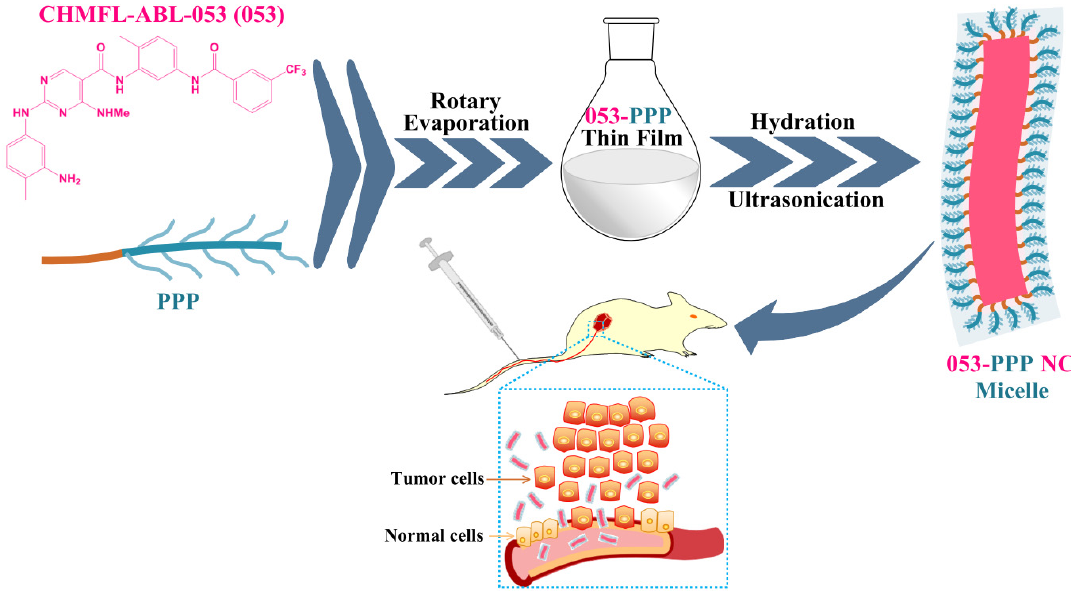
Figure 1. Schematic illustration for fabrication of the worm-like 053-PPP nanocrystal micelle, and its delivery to tumor tissues, in K562-tumor-bearing xenograft mice.